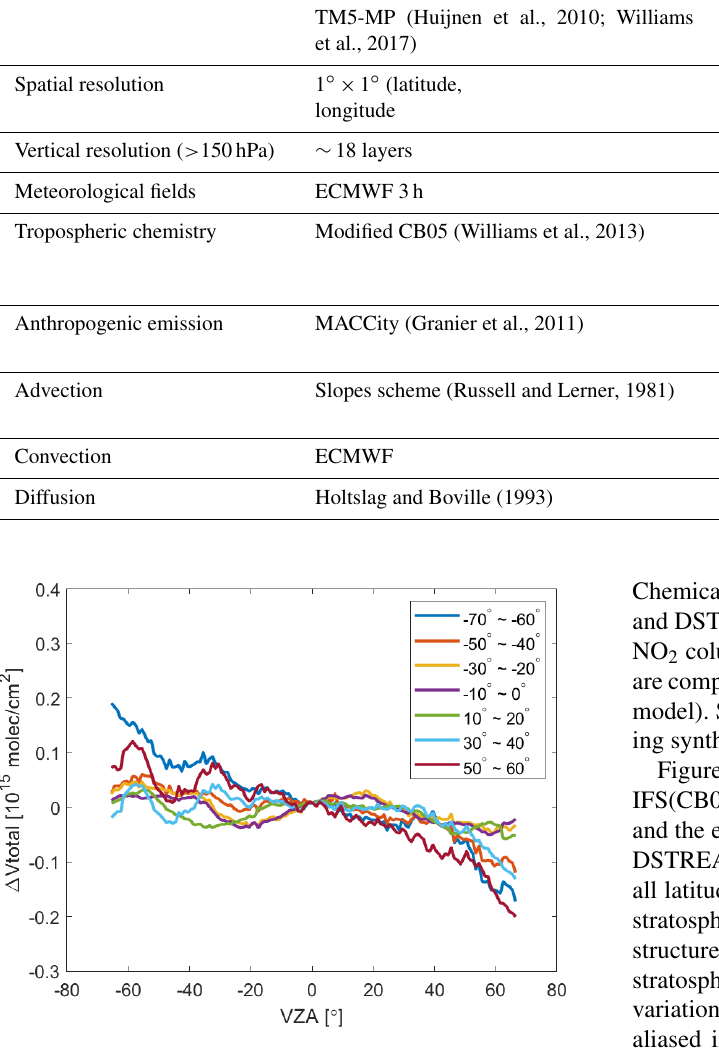
Figure 3. VZA dependency of TROPOMI total NO 2 columns (com- pared to nadir) at different latitudes in January 2019. The VZA is defined negative for observations on the west side of the orbit swath. The de-striping is implemented